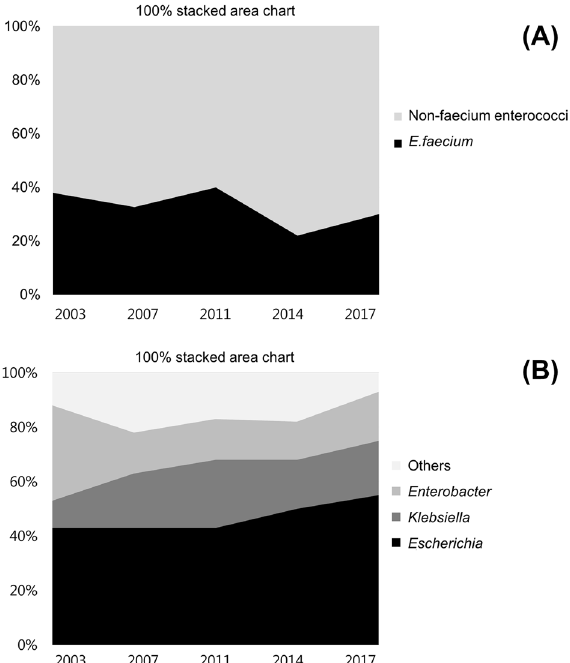
Figure 2. Relative proportions of enterococci and Enterobacteriales isolates obtained from the bile of gallbladder in acute cholecystitis patients over time. ( A ) The relative proportion of E. faecium isolates decreased over time, but there was no statistical significance ( P = 0.207). ( B ) Among genera of the order Enterobacteriales, there was a significant increase in the relative proportion of Escherichia ( P = 0.008), whereas there were no significant changes in the relative proportions of infections caused by Klebsiella ( P = 0.212), Enterobacter ( P = 0.637), or other Enterobacteriales ( P =